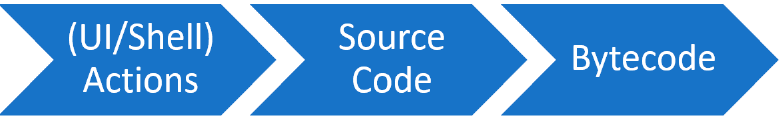
Figure 3. From user actions to byte code that can be executed by the DSM.